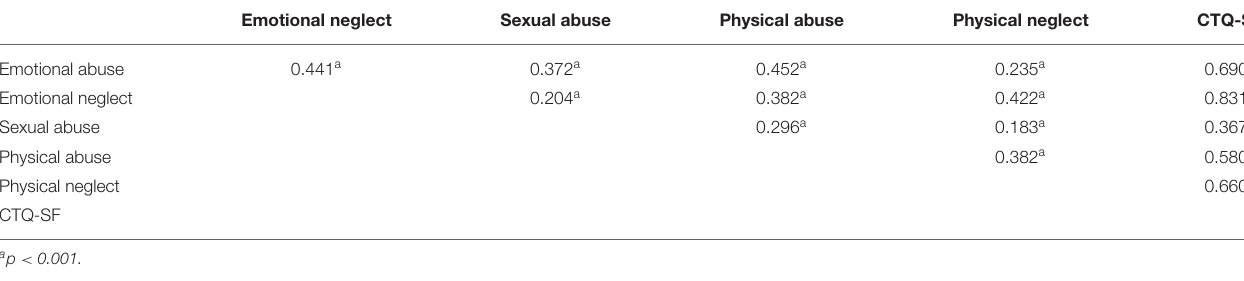
TABLE 2 | Correlations between ACE factors.